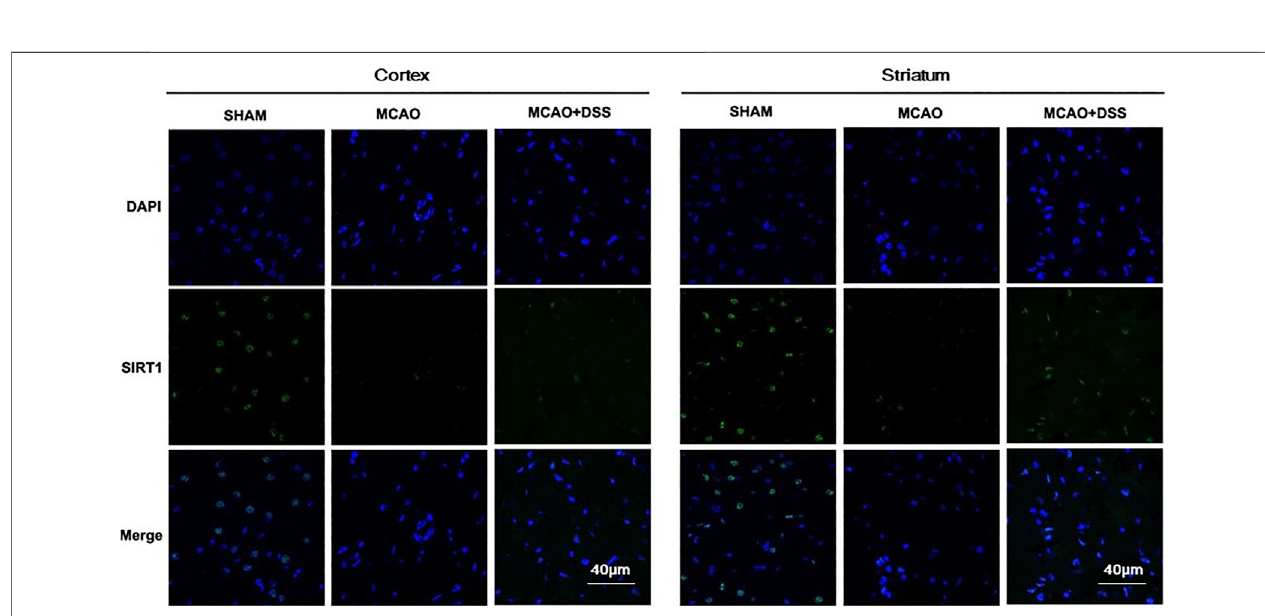
FIGURE5| DSSup-regulated theexpression ofSIRT1incortex andstriatumoftheischemia-reperfused brains.Representativeimmunestaining(green)forSIRT1 in cortex (left) and striatum (right) of the ipsilateral side in each group; blue represents DAPI positive signal.